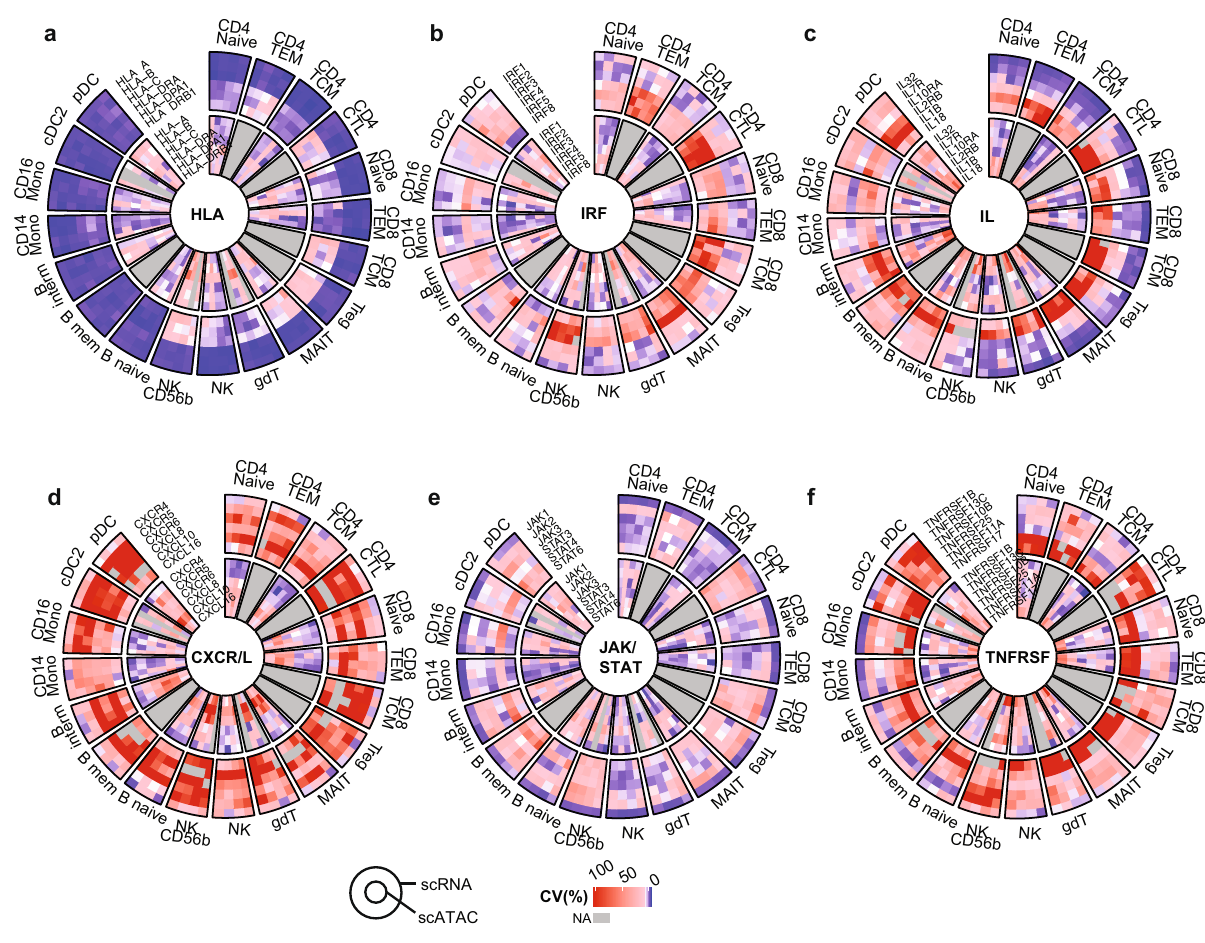
Fig. 6 | Circos plots showing stability patterns of fi ve protein families. a Circos plot displaying stability patterns of gene expression (outer circles) and gene score (inner circles) of human leukocyte antigen (HLA) protein family (member: HLA-A, HLA-B, HLA-C, HLA-DRA, HLA-DPA1, and HLA-DRB1). Samples with missing data or cell types with low cell counts are shown in grey. b – f Same as ( a ) but for ( b ) interferon regulatoryfactors(IRFs;member:IRF1, IRF2,IRF3, IRF4,IRF5,and IRF8), ( c ) interleukins (ILs; member: IL32, IL7R, IL10RA, IL2RB, IL1B and IL18), ( d ) che- mokine (C-X-C motif) receptor/ligand (CXCR/L) protein family (member: CXCR4, CXCR5, CXCR6, CXCL8, CXCL10, and CXCL16), ( e ) Janus kinase (JAK) and signal transducer and activator of transcription (STAT) protein family (member: JAK1,